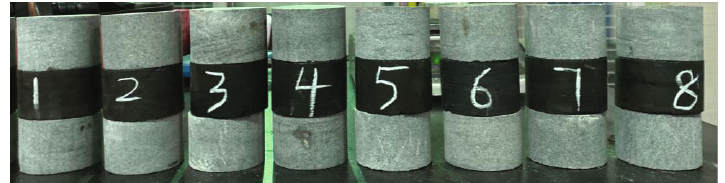
Figure 8: Partial composite coal-rock specimen.